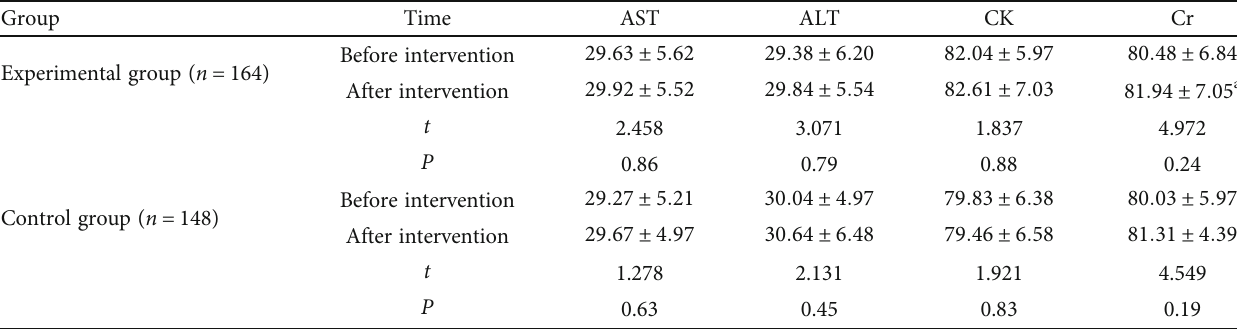
Table 5: Comparison of safety index between two groups ( (cid:1) x ± s